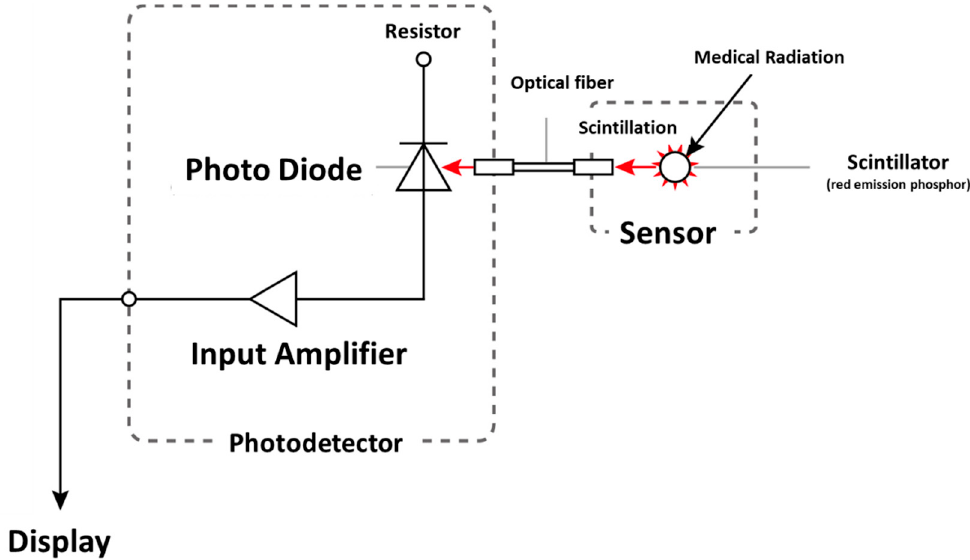
Figure 4. Operational principle of novel real-time radiation system.